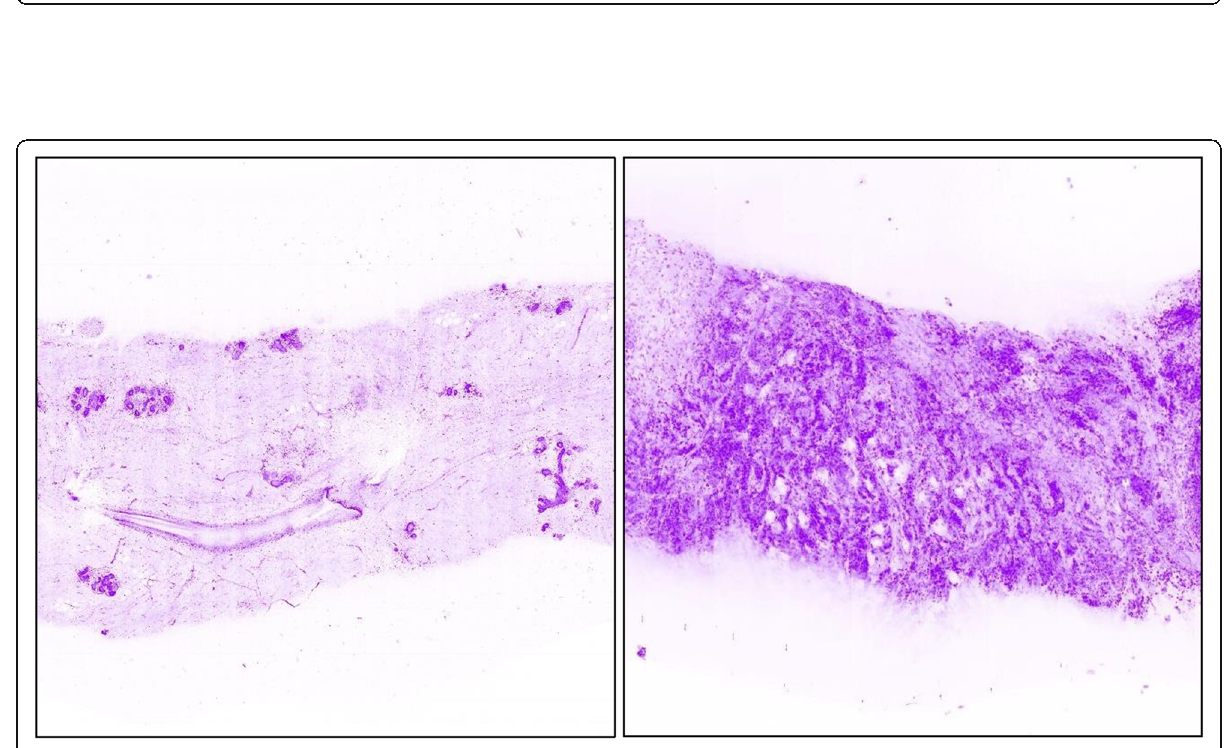
Fig. 2 Human breast biopsy imaged with the HistologTM Scanner (left) and the corresponding H&E microscopy slide used for pathological final assessment (right). Staining with a fluorescence dye was performed before on-site scanning. The images were displayed with an artificial coloring of the grey values, which mimics an H&E stain and is adapted to the needs of the clinical users. The encircled areas indicate invasive breast cancer location as detected by the pathologists in both images using the full resolution zooming feature to reveal morphological